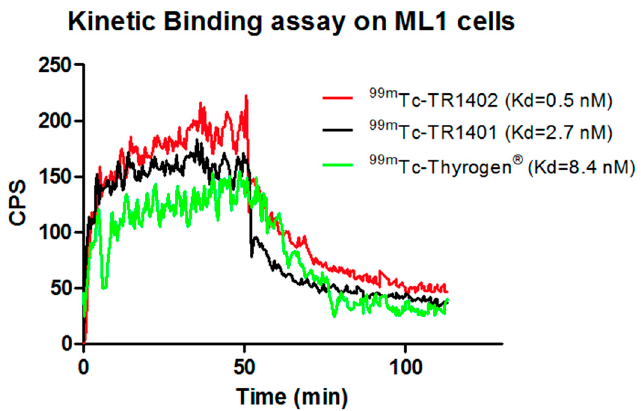
Figure 1. Real-time kinetic binding assay on ML1 cells with 99m Tc-TR1402 (red line), 99m Tc-TR1401 (black line), and 99m Tc-Thyrogen (green line). Highest affinity was detected for 99m Tc-TR1402.